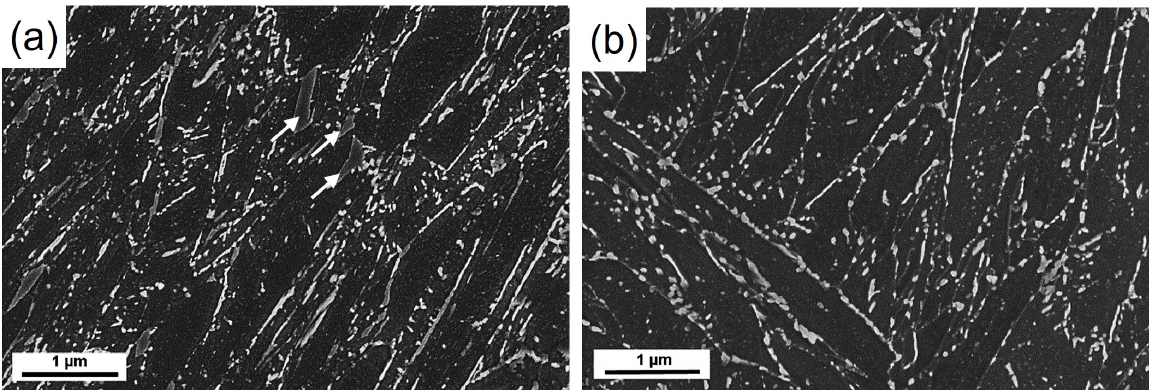
Figure 4. Results for respondents who have a driver’s license and for respondents who are in the Figure 5. Images were taken in SEM on electropolished surfaces. Arrows point at areas of retained process of training in driving schools for: ( a ) PncSL; ( b ) PST; ( c ) AMS; and ( d ) AS. austenite. Rod-like particles within or on the martensitic lath boundaries are iron-carbides ( a ) Samples tempered at 600 ◦ C for 0 h and ( b ) after 24